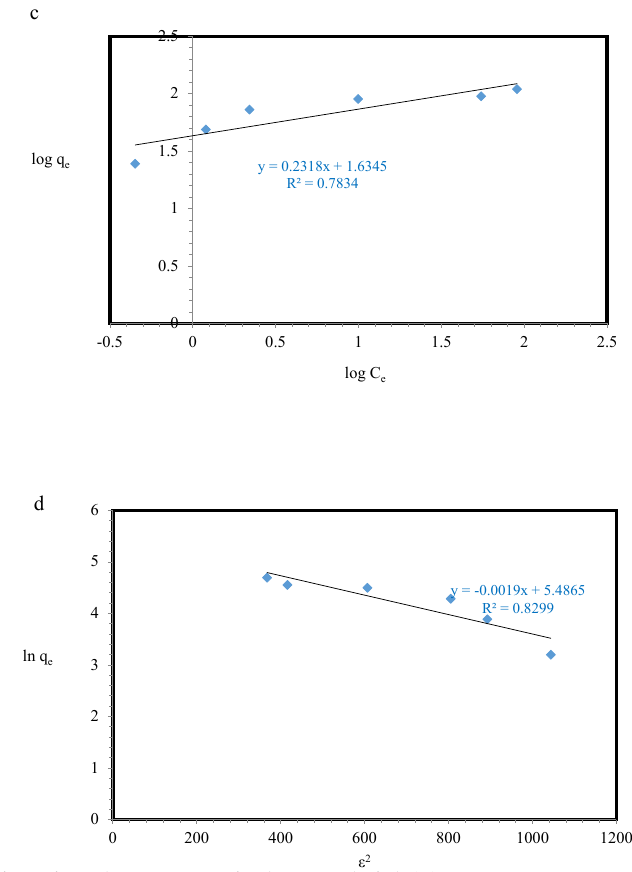
Table 2. Isotherm parameters obtained for Pb (II) adsorption onto Fe